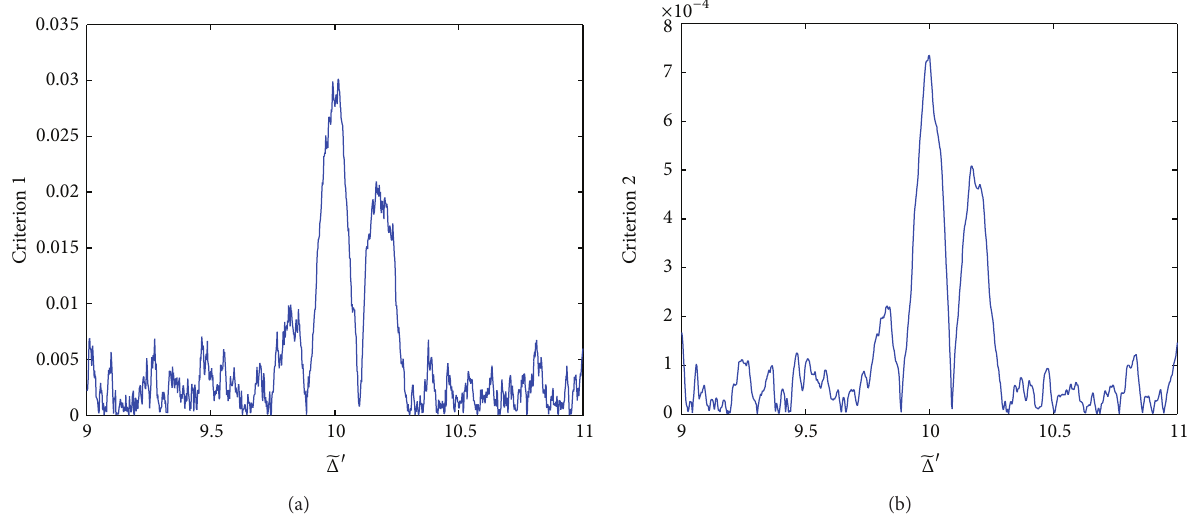
Figure 6: Plots of criteria values toward guessed length of embedding interval: (a) criterion 𝐶 1 ; (b) criterion 𝐶 2